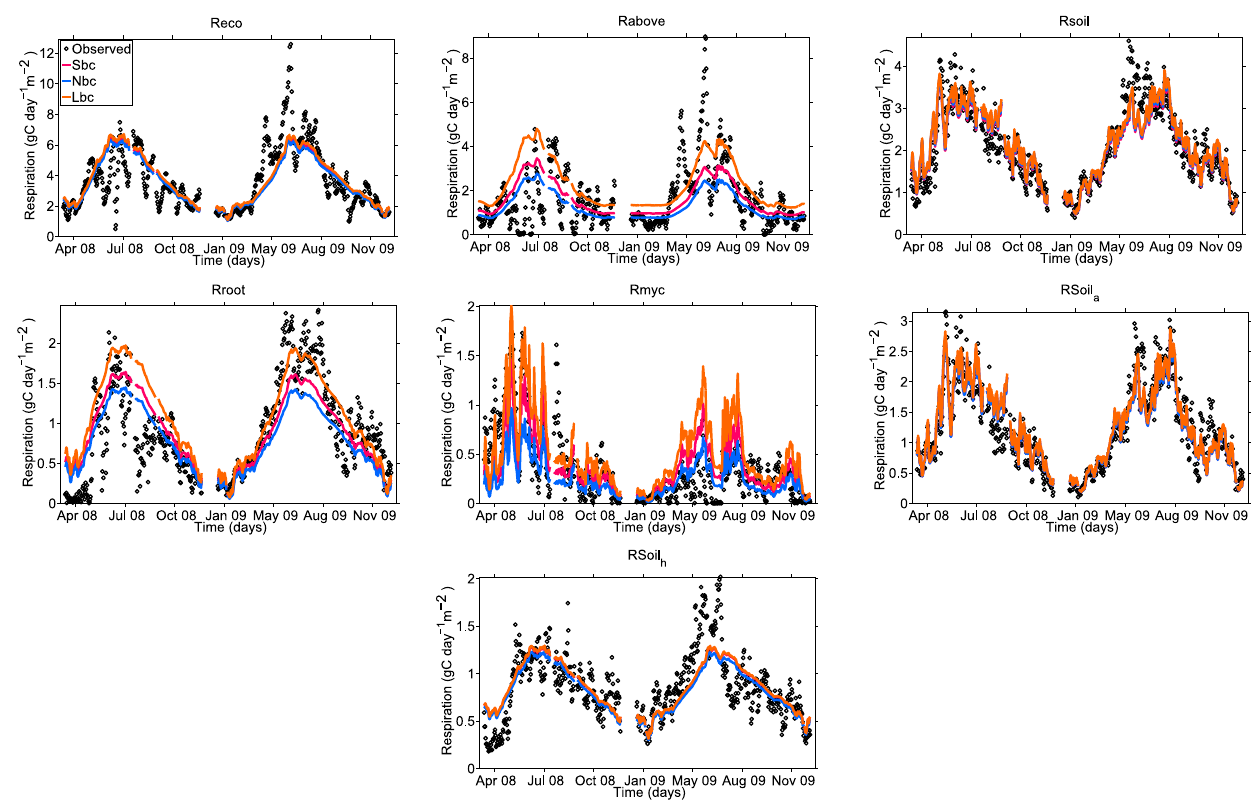
Figure 7. Observed and predicted outgoing CO 2 fluxes; 613 time steps of daily averaged CO 2 effluxes for 2 years at the Alice Holt oak forest site. The predicted values are generated with the models automatically built by the GEP approach with the settings given in Table 1 for the following types of respiration, R eco , R above , R soil , R root , R myc , R soil b ias c orrection terms: s mear term, n aive, and l og-normal